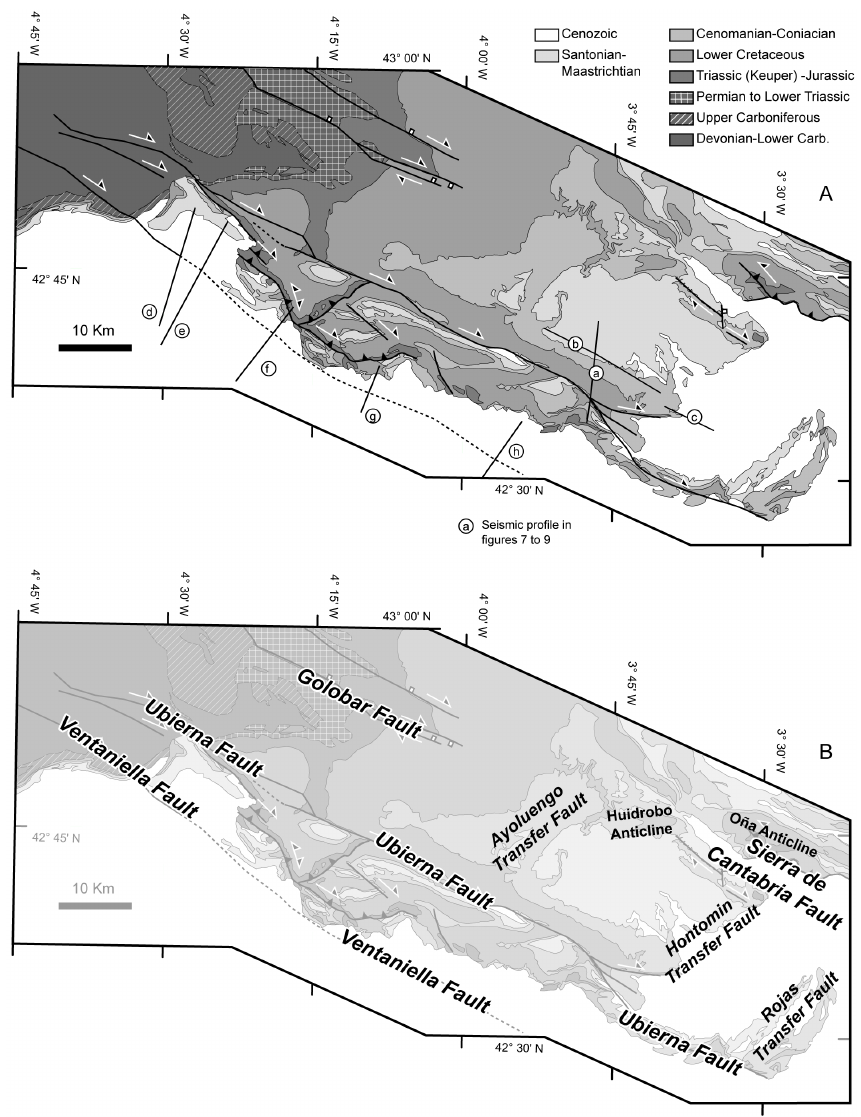
Fig. 7. (A) Geological map of the Plataforma Burgalesa domain (modified from Tavani et al., 2011a), with traces of seismic lines. (B) La- belling of major